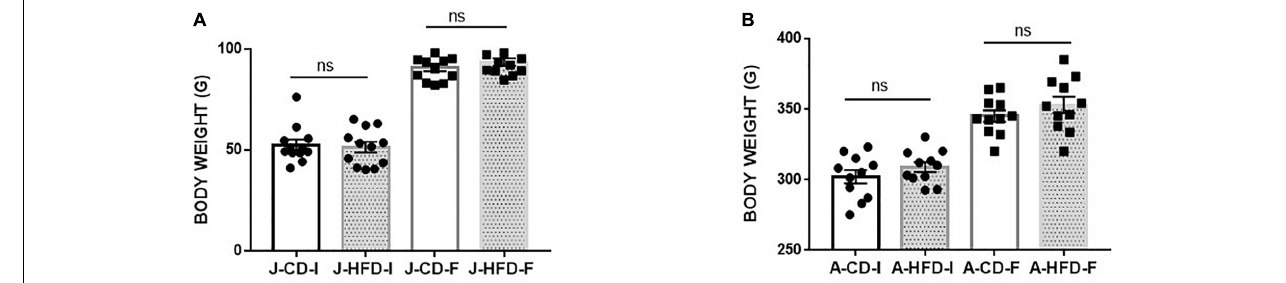
FIGURE 2 | Body weight gain during 7-day high-fat diet (HFD) exposure. Juvenile [J; post-natal day (PND) 21–28] and adult (A; PND 60–67) animals body weight was measured immediately prior to and immediately after completing a 7-day HFD or standard chow diet (CD) regimen. The change in body weight showed no significant effect of Diet (n.s) or of Age × Diet interaction (n.s).The group were following: (A) HFD fed animals [Juvenile-Initial (J –HFD-I), Juvenile-Final (J-HFD -F), N = 12 and Adult-Initial (A-HFD-I), Adult-Final (A-HFD-F), N = 11]. (B) CD-fed animals [Juvenile-Initial (J –CD- I), Juvenile-Final (J-CD-F), N = 12 and Adult-Initial